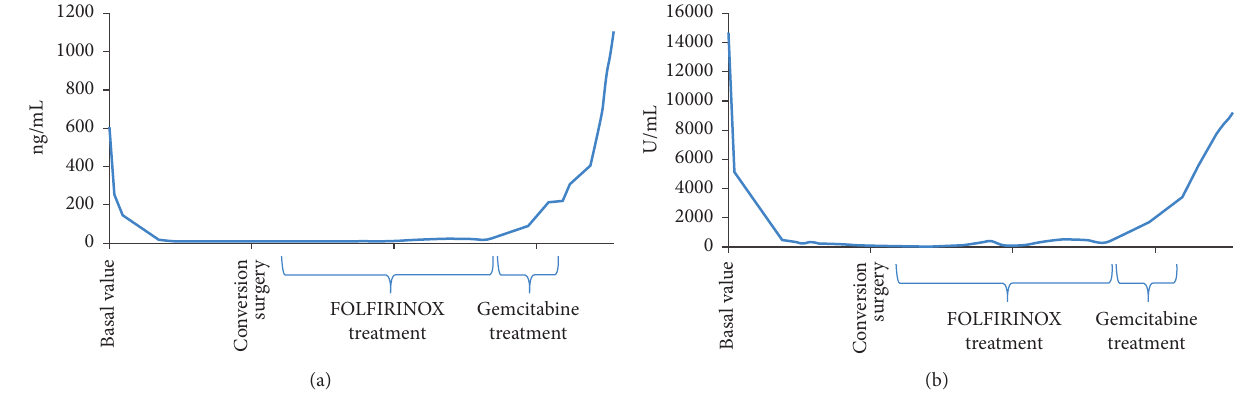
Figure 2: Trend of neoplastic markers: CEA (a) and Ca 19.9 (b).